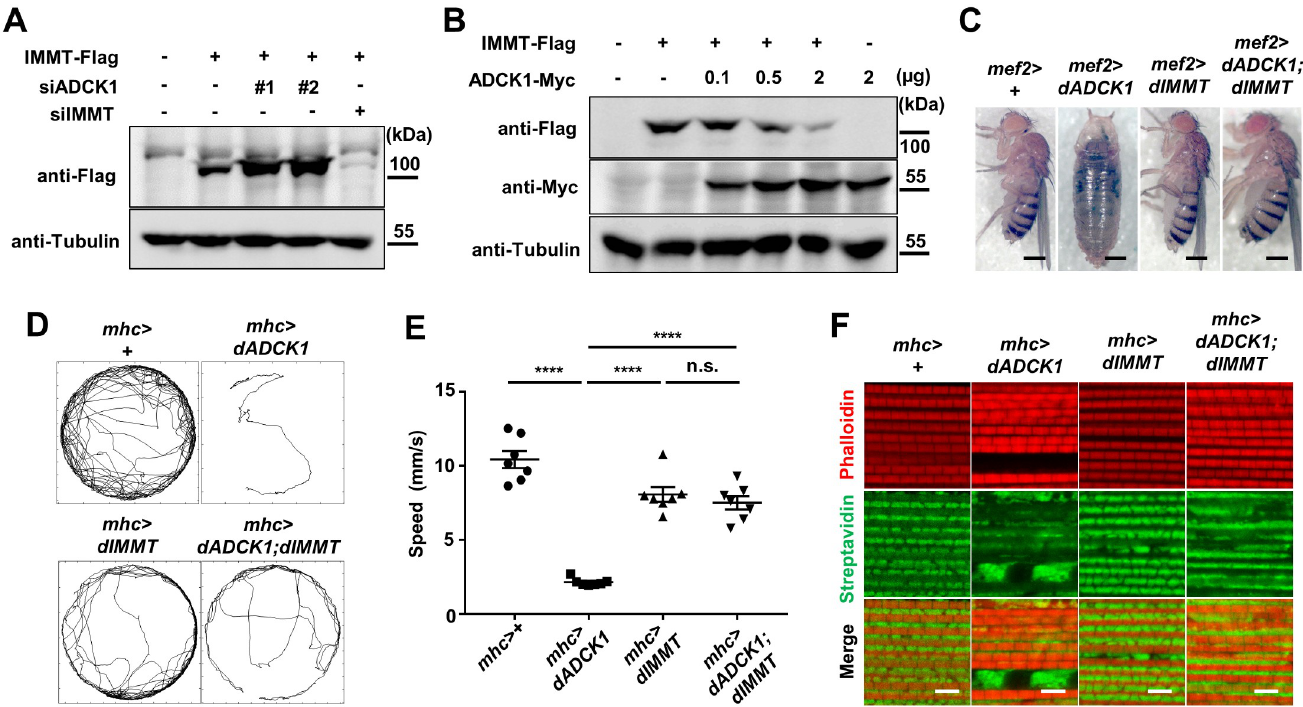
Fig 7. IMMT is a downstream target of ADCK1. (A) HEK293T cells were transfected with scramble siRNA (Scr), siADCK1s (#1 and #2), or siIMMT as indicated. WCL were prepared and analyzed for immunoblot with anti-Flag and anti-tubulin antibodies. (B) HEK293T cells were transfected with IMMT-Flag and ADCK1-Myc as indicated. WCL were prepared and analyzed for immunoblot analyses with anti-Flag, anti-Myc and anti-tubulin antibodies. (C) Whole body images of the flies with indicated genotypes. Scale bars, 0.5 mm. (D) Movement trajectories of the adult flies with indicated genotypes. (E) Comparison of the mean value of walking speed with indicated genotypes, n = 7. ���� , p < 0.0001; n.s., not significant by unpaired t-test. (F) Fluorescent confocal microscopy images of the adult thoraces with indicated genotypes. Streptavidin (green) and phalloidin (red) staining were used to mark mitochondria and muscle actin fibers, respectively. Scale bars, 5 μ